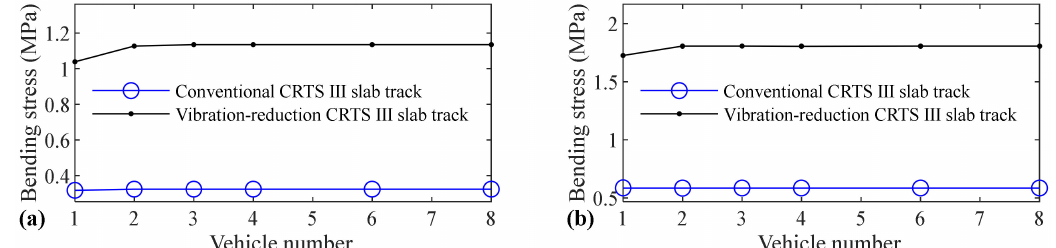
Figure 13. Relation between vehicle number and positive bending stress of slab: ( a ) without and ( b ) with random track irregularity.